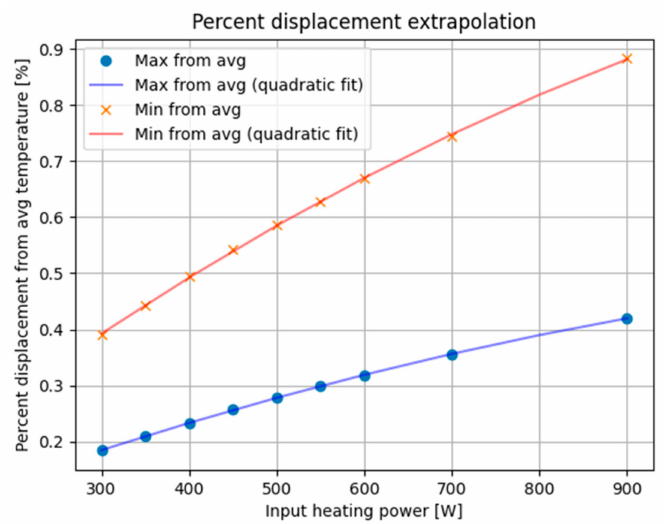
Figure 9. Maximum percent deviation from the average temperature for various power